Question: What visual encoding does this figure use to show its data?
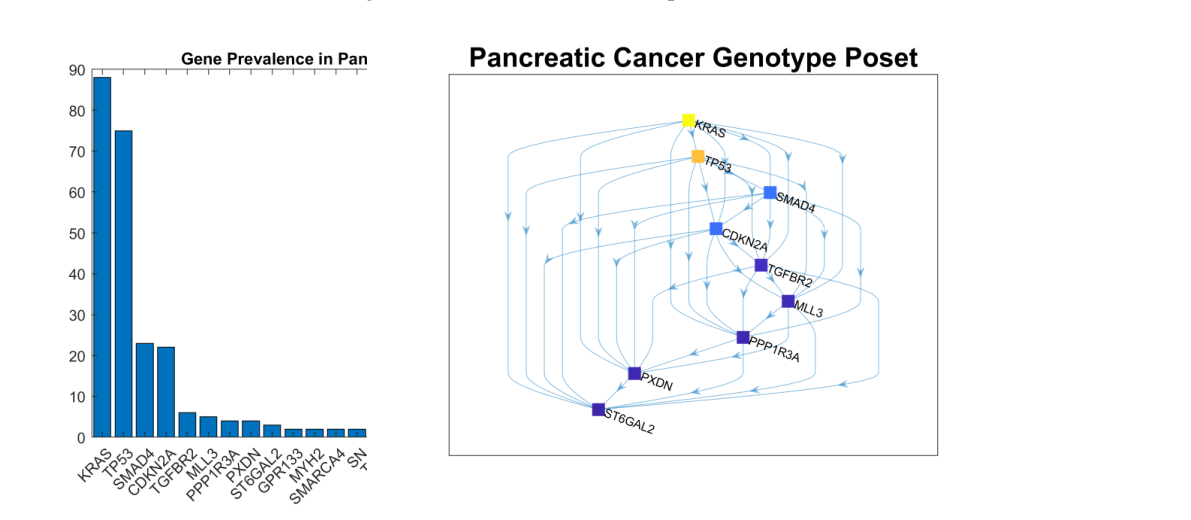
Answer: histogram